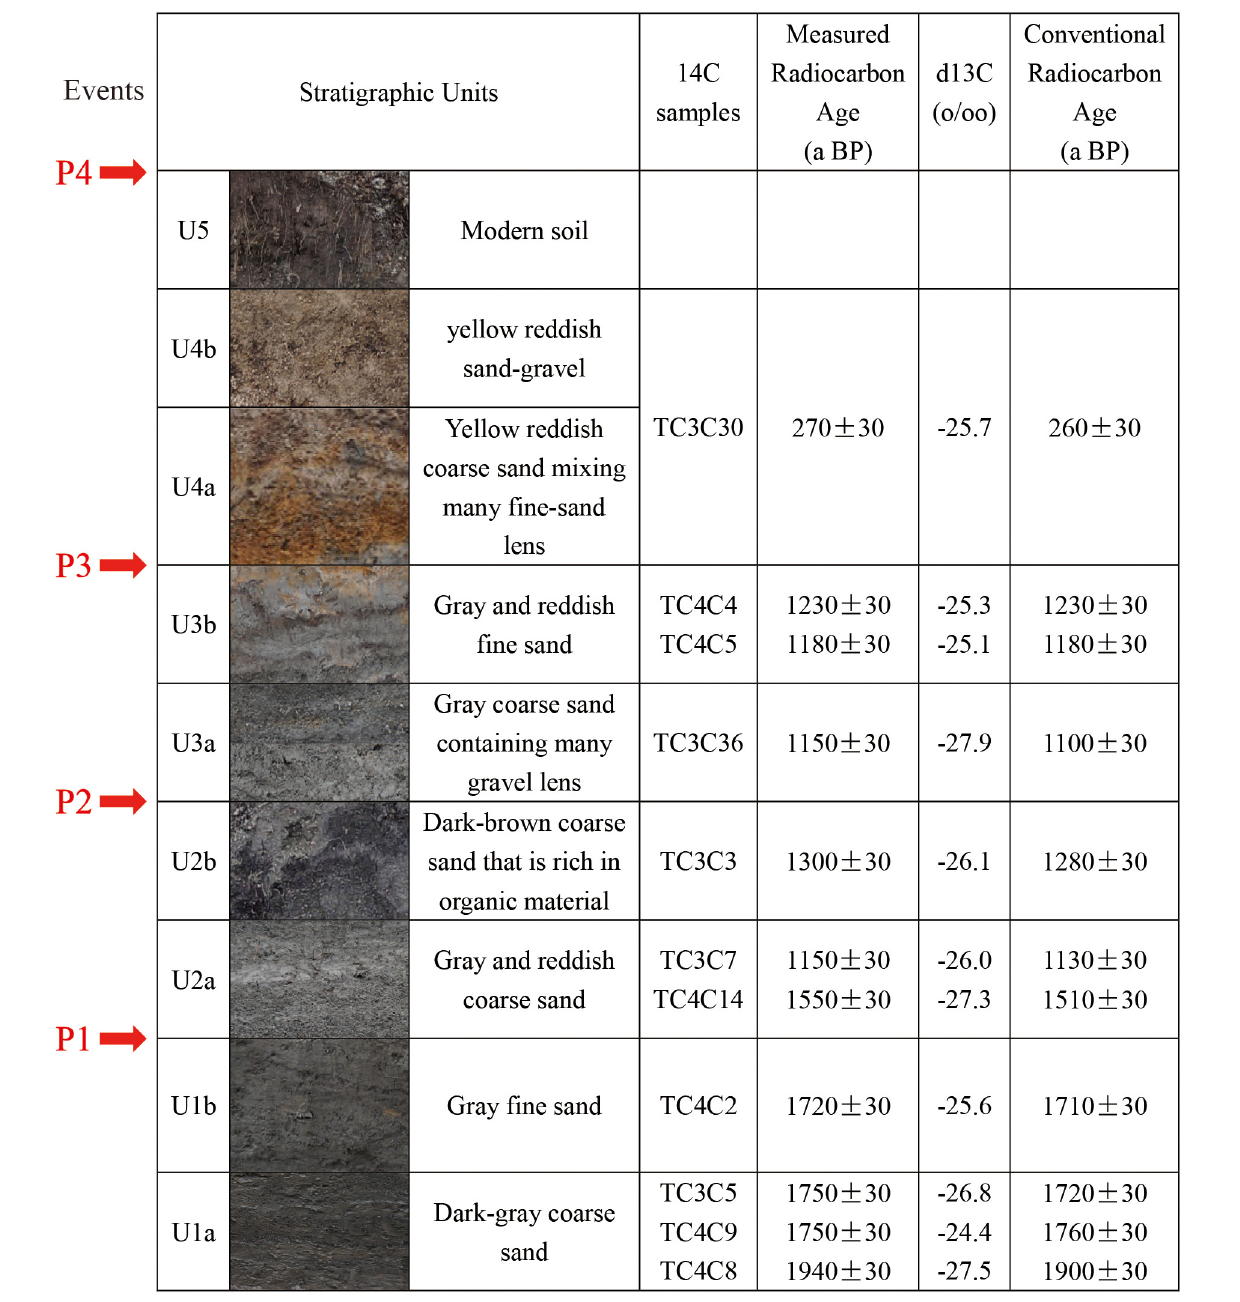
stress accumulation and faster-than-average stress release.